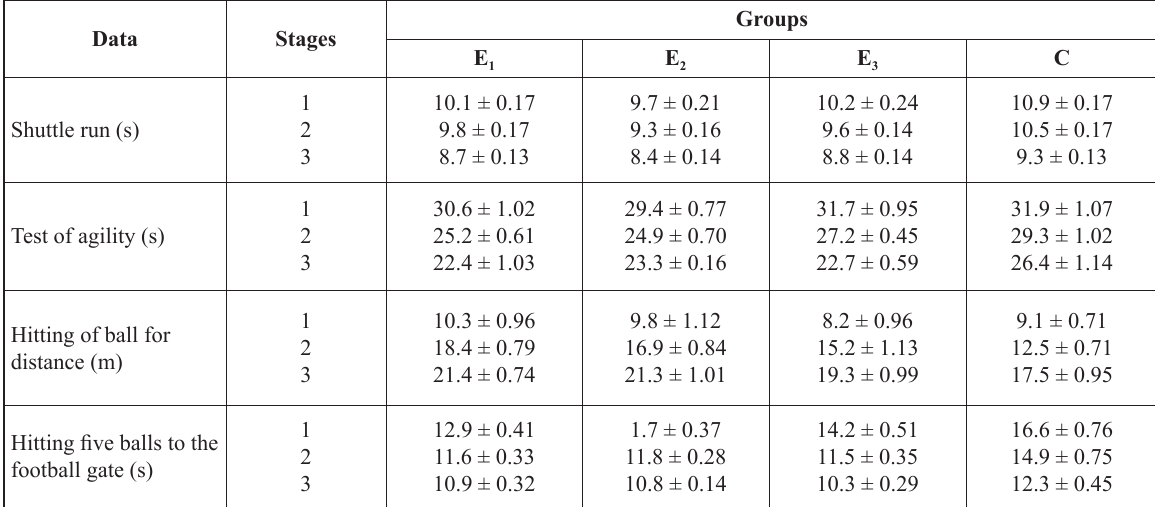
Table 3. The results of specially prepared index (X ± Sx)